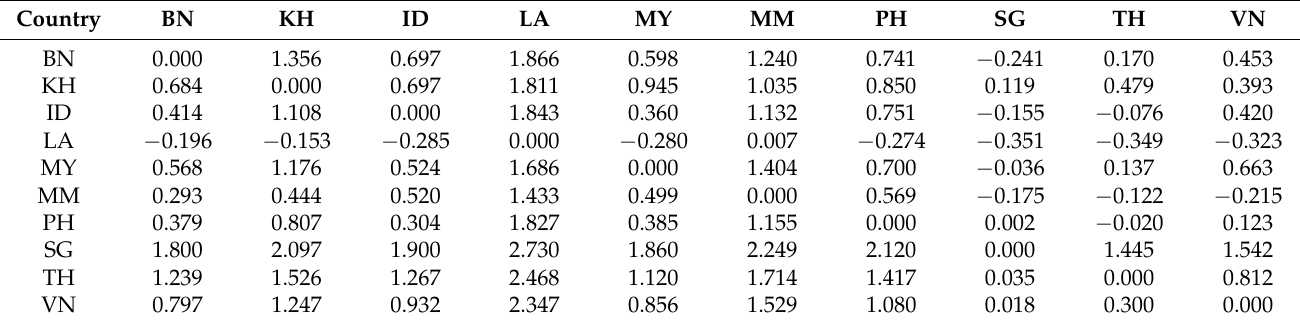
Table A6. The level of dominance with the loss attenuation coefficient µ =